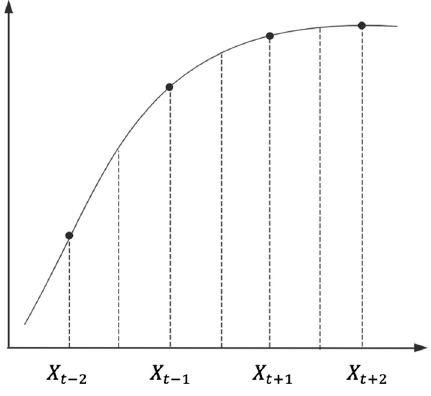
Figure 2. The interpolation of the data. Some data (data with a too-long data period) are interpolated to align the data period. Some data (data with a too-short data period) used averages to align the data period. For data feature extraction, all factors should obtain the same data period. Interpolated data or average data are more reasonable.